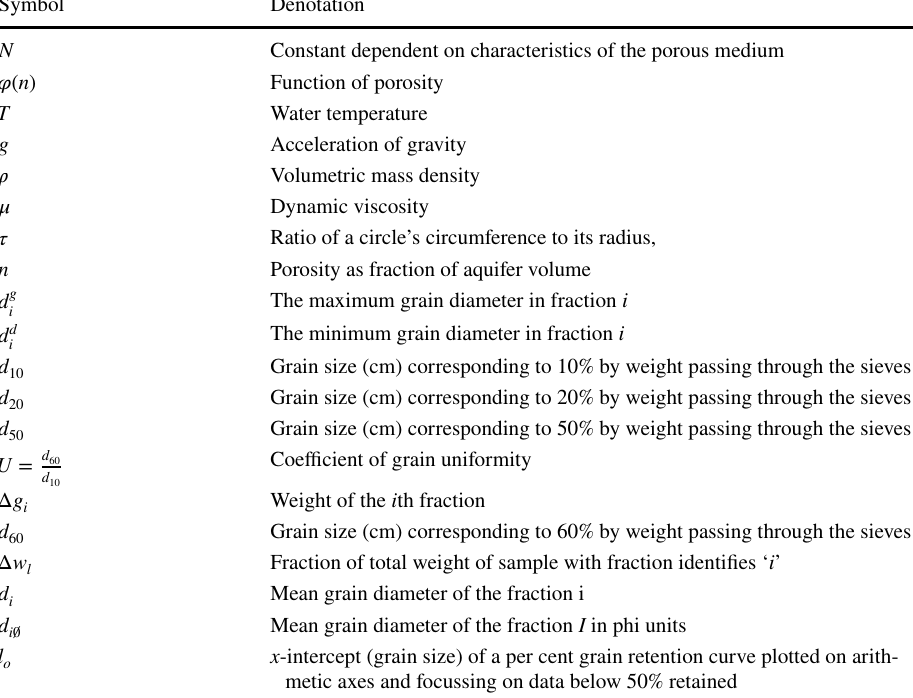
Table 2 List of